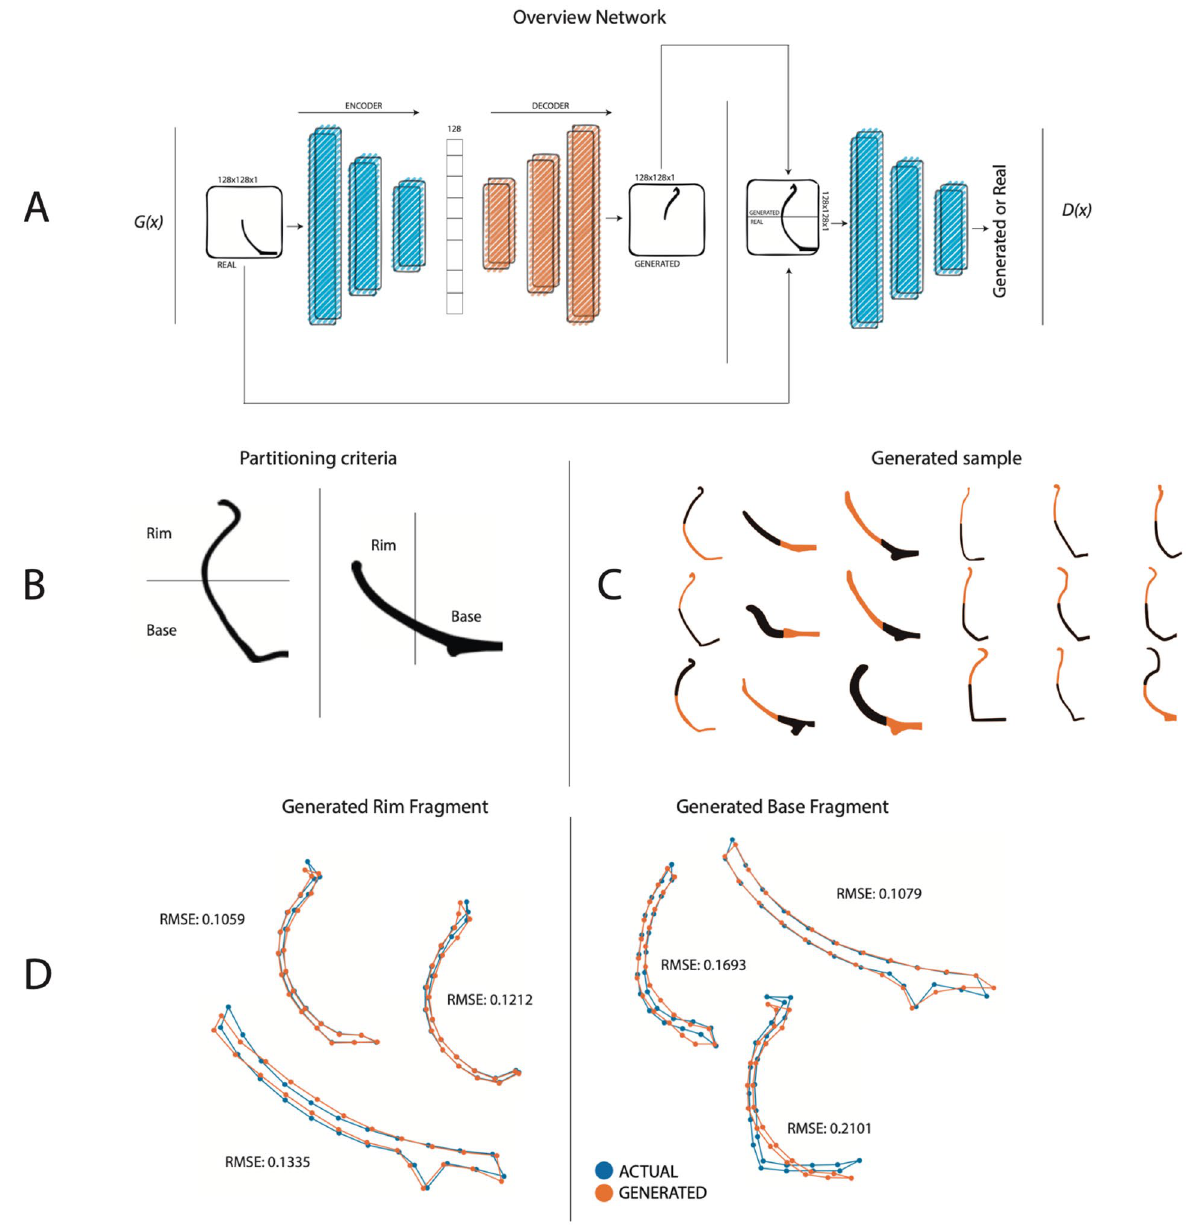
Figure 1. Overview of the proposed approach. ( A ) IberianGAN architecture. The G ( x ) generator is based on an encoder-decoder architecture. Upon receiving a fragment of pottery, the encoder transforms it into a vector and then the decoder generates the missing or unknown fragment. The discriminator D ( x ) receives the complete profile to determine if it is true or false. ( B ) Criteria for profile partitioning into rim and base of profiles. ( C ) Examples of IberianGAN generated samples from fragments for both open and closed shapes (shown in lighter color). ( D ) Semi-landmark analysis and RMSE values as comparing actual and artificially generated